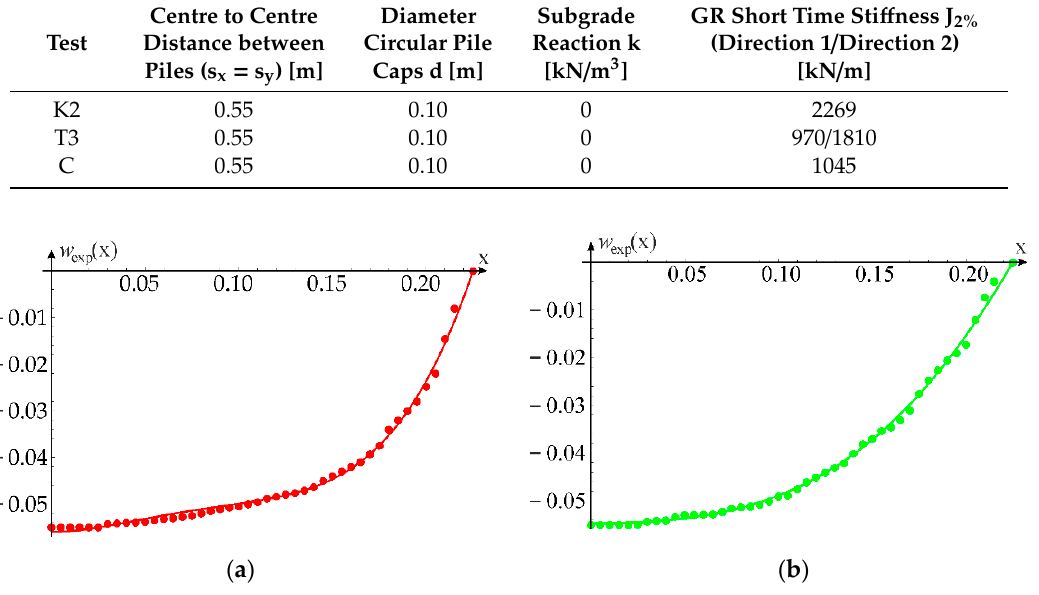
Figure 5. Approximation of the C_L ( a ) and C_R ( b ) test results using a 7th degree polynomial.